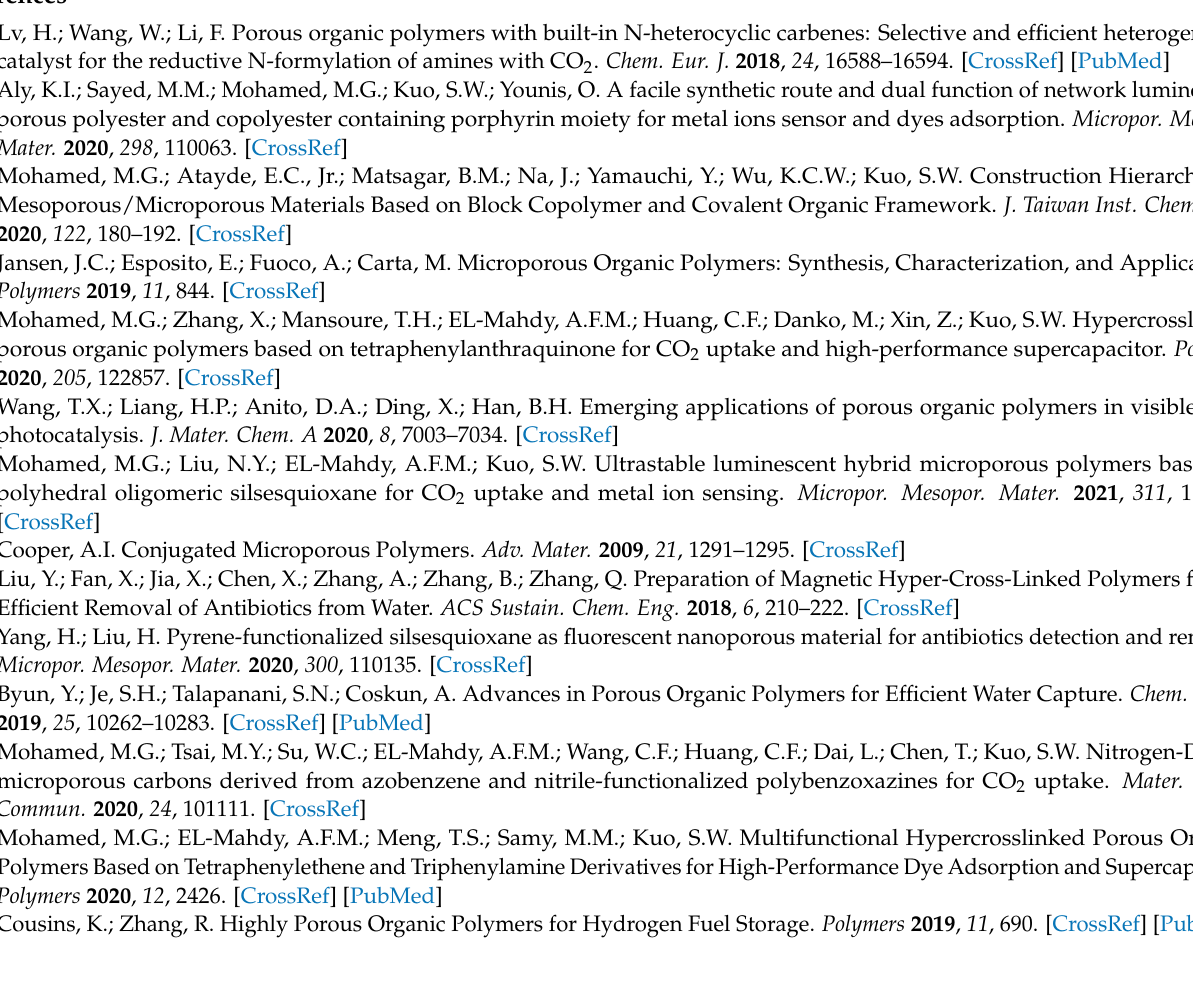
Figure S3: 1 H NMR spectrum of TPE. Figure S4: 13 C NMR spectrum of TPE. Figure S5: TEM images of POSS-TPP (A,B,C) and POSS-TPE (D,E,F). Figure S6: Repeated I 2 uptake experiments for (A) POSS-TPP and (B) POSS-TPE. Table S1: Performance data of POSS-TPP and POSS-TPE